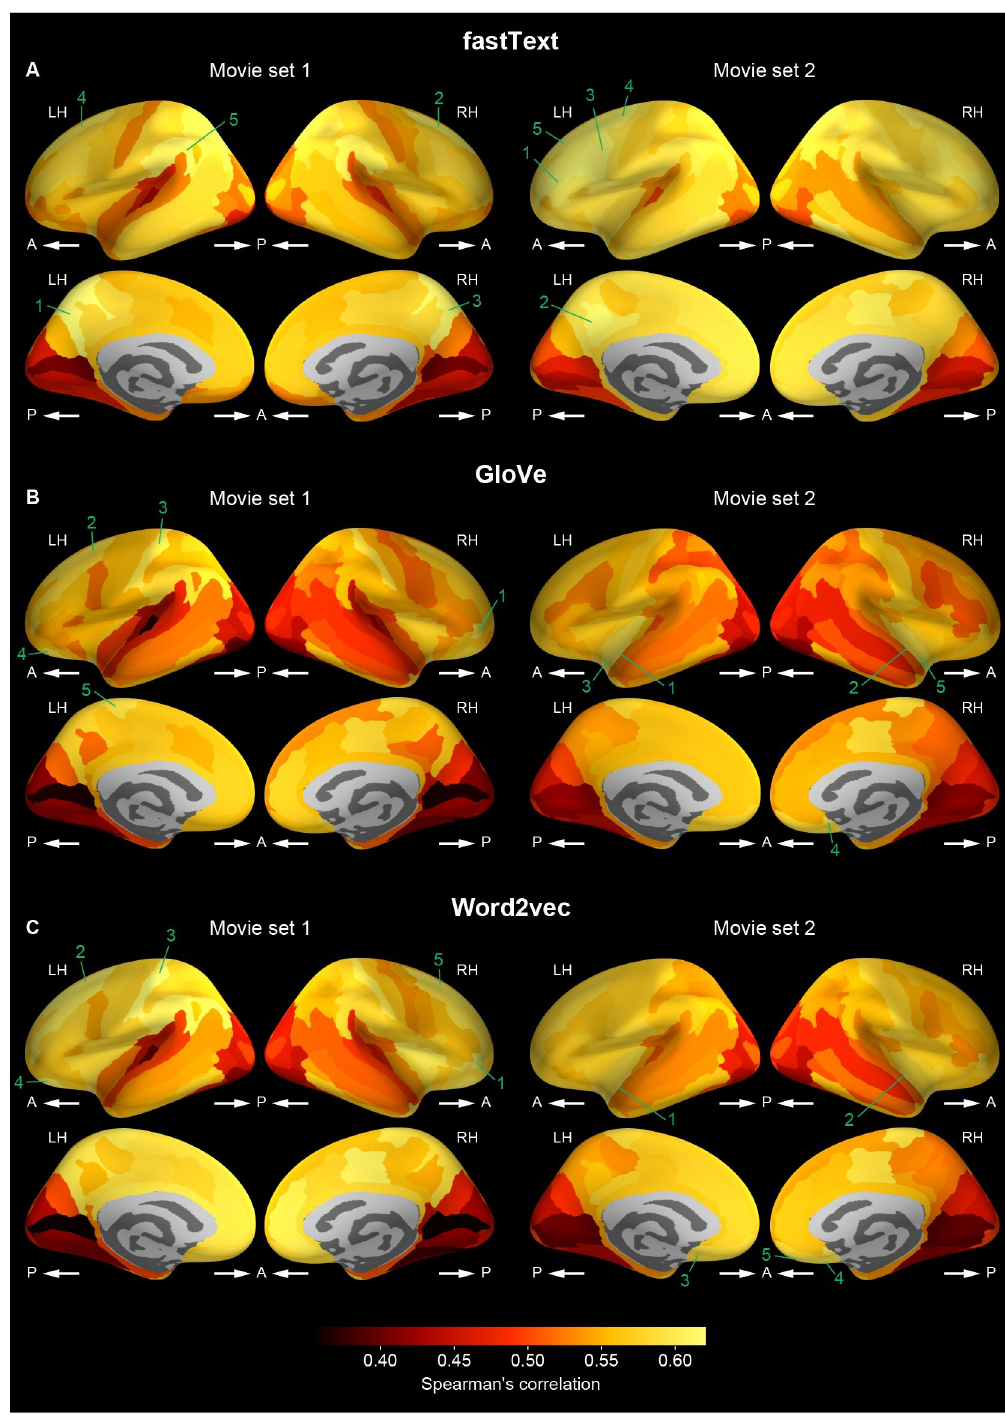
Fig 9. Cortical mapping of brain–behavior correlations of noun dissimilarity. Spearman’s correlation coefficients between brain- and behavior-derived noun dissimilarity matrices were calculated within each cortical region and mapped onto the cortical surface of a reference brain for each of fastText ( A ), GloVe ( B ), and word2vec ( C ) models (vector dimension = 1000) and for each of movie sets 1(left) and 2 (right). Brighter colors indicate regions that have larger correlation coefficients. The five cortical regions with the highest correlation coefficients are numbered in a descending order separately for each type of word vectors and for each movie set. The names of these regions are shown in S15 Table. Other conventions are the same as in Fig 4.